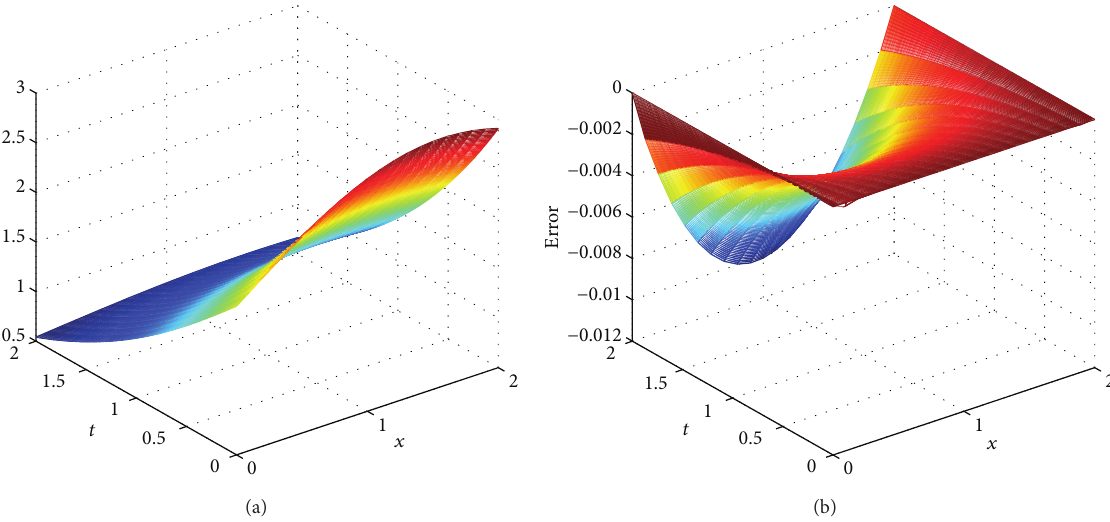
Figure 6: The numerical solution of ̂𝑢(𝑥,𝑡) (a), the error 𝑢(𝑥,𝑡) − ̂𝑢(𝑥,𝑡) (b) with Δ𝑥 = 0.1 , Δ𝑡 = 0.01